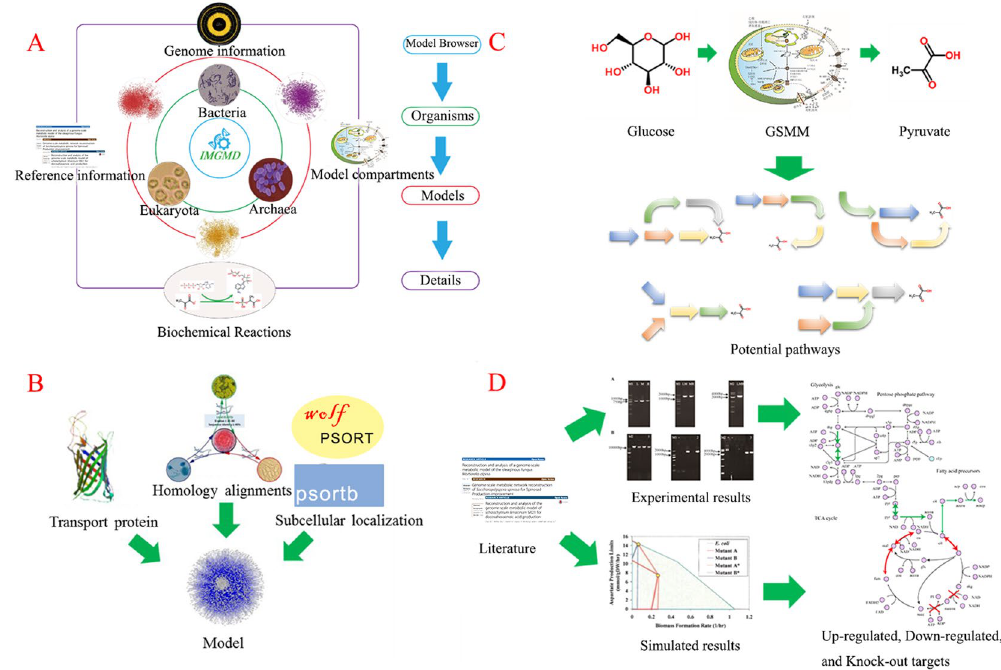
Figure 1. Summary of four functional modules in IMGMD. ( A ) The ‘model browser’ function; ( B ) the process of model auto-reconstruction; ( C ) pathway mining in a certain model organism; ( D ) gathering experimental and simulated results to identify metabolic engineering